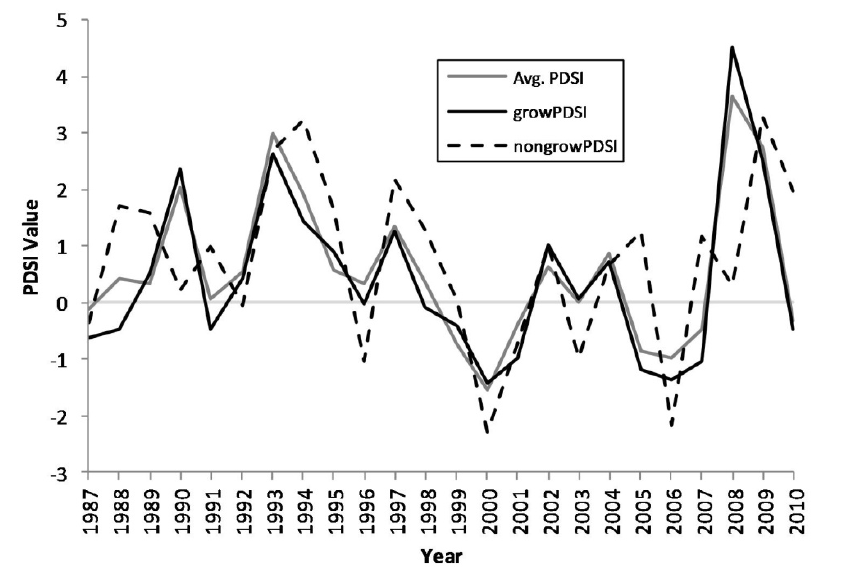
Figure 2. Growing season, non-growing season, and annual average Palmer drought severity index (PDSI) values,